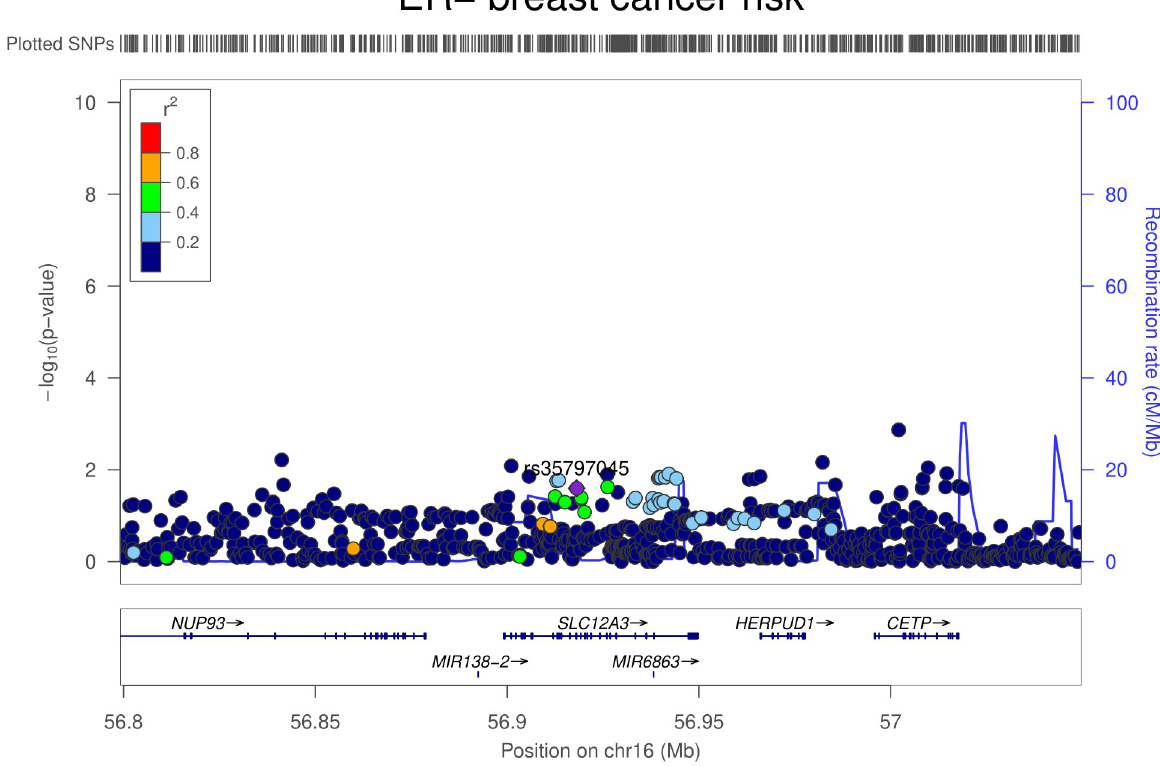
Fig 6. Regional Manhattan plot of associations of SNPs with ER − breast cancer risk ± 300kb from the SNP used to proxy SBP (rs35797045) in the SLC12A3 region. ER, estrogen receptor; Mb, Megabase; SBP, systolic blood pressure; SNP, single-nucleotide polymorphism.